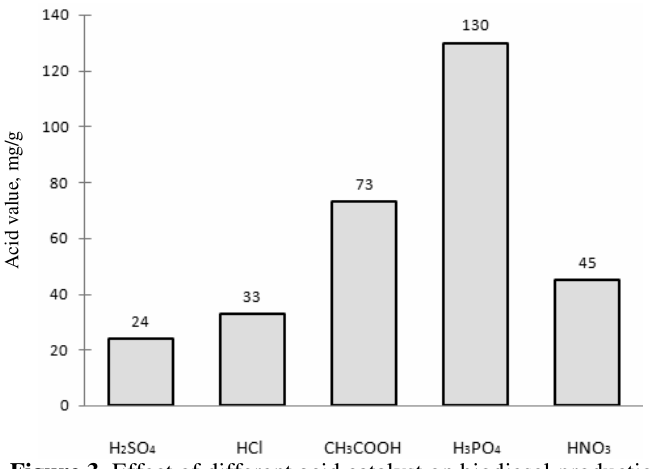
Figure 3. Effect of different acid catalyst on biodiesel